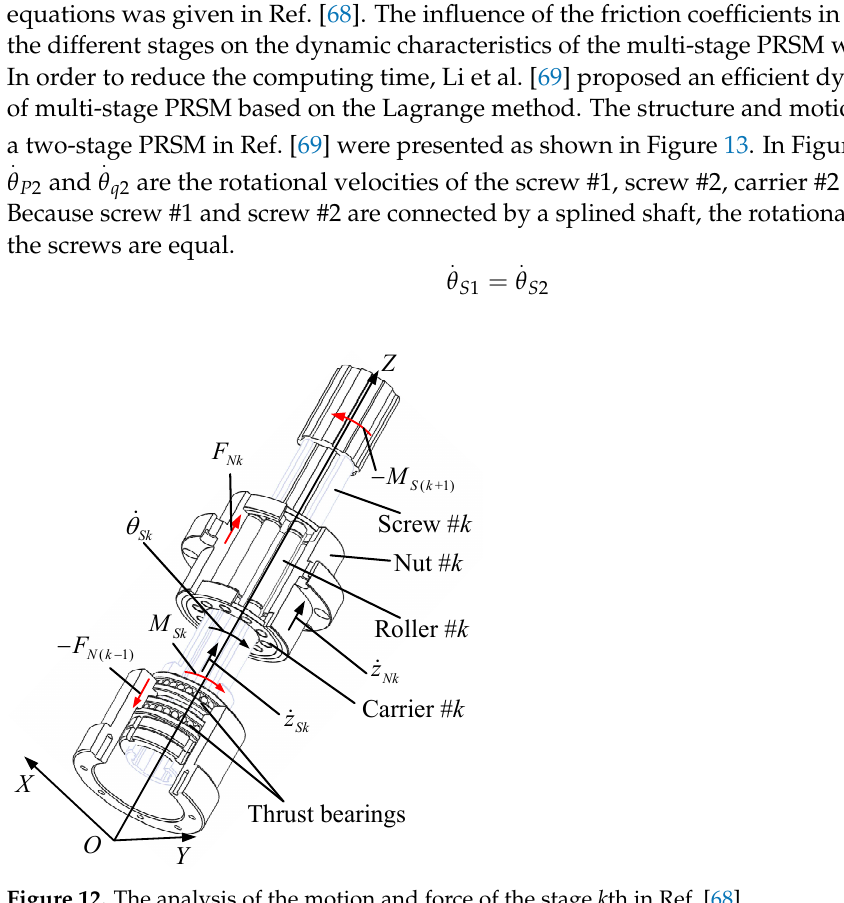
Figure 12. The analysis of the motion and force of the stage k th in Ref. [68].